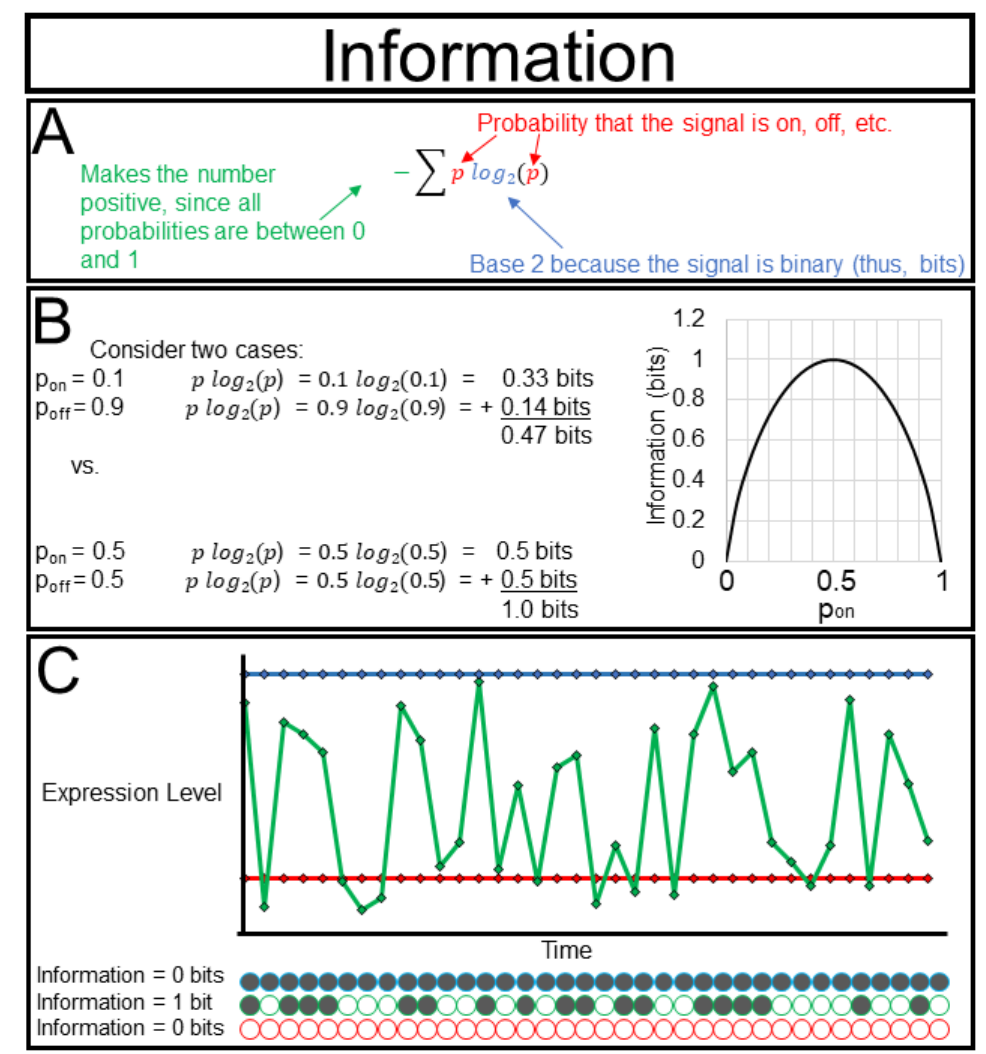
Figure 3. Information: Information is a formally defined value ( A ) that increases as variables spend more time in multiple states ( B ). Signals that frequently shift between “active” and “inactive” states (green) contain more Information than signals that are either always on (blue) or always off (red) ( C ).